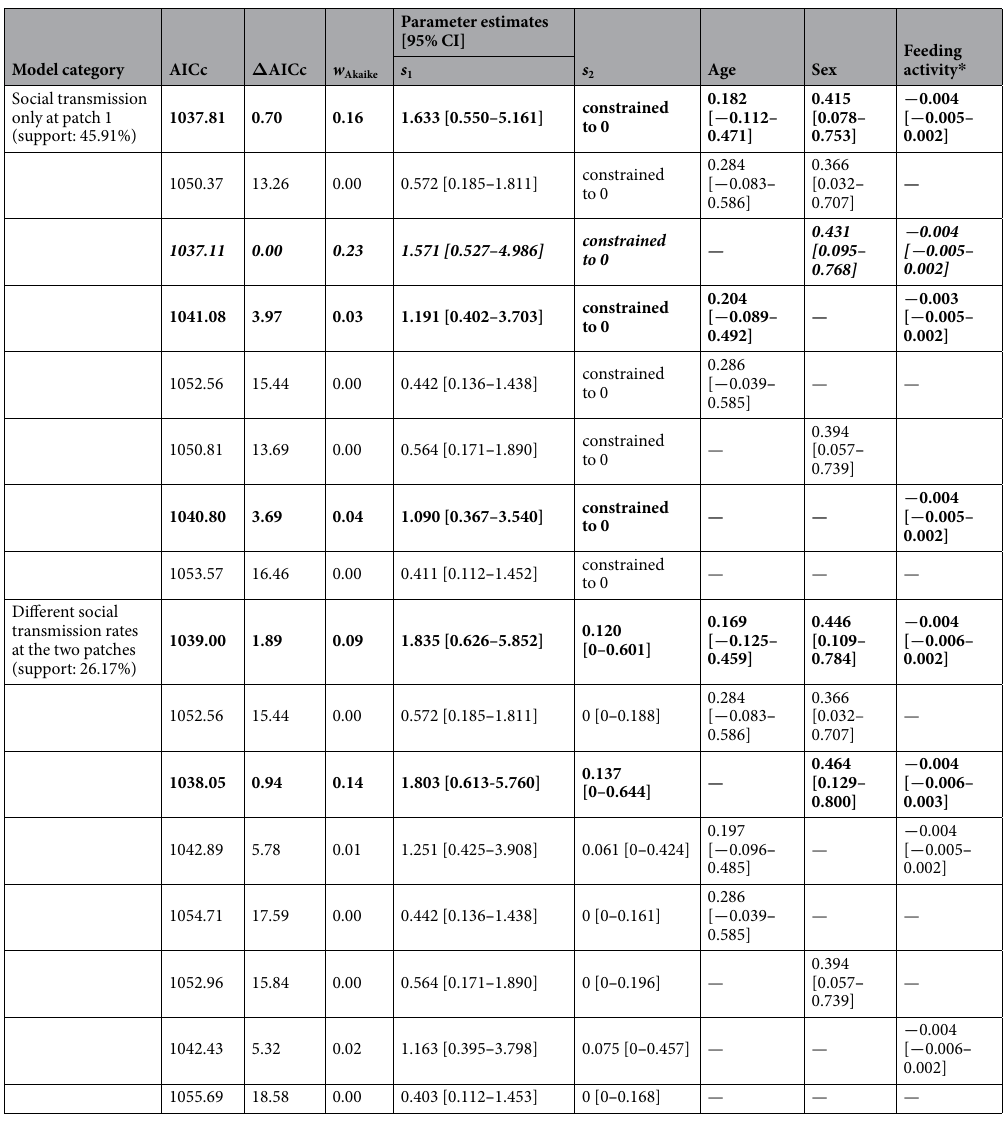
Table 2. Model parameter estimates and their conditional profile likelihood 95% confidence intervals in the two best supported categories of models fitted with following-based networks. * As feeding activity was measured as the total number of visits at the central feeder, the estimated decrease in log odds of discovery corresponds to one unit increase in feeding activity. The model with the lowest AICc is written in italics, while the ‘best models’ set (within 4 Δ AICc) on which we based our inference is written in bold. Other model categories (same social transmission rate at both patches, social transmission only at the second patch, no social transmission at either patches) had very low overall support ( ≤ 0.70%). AICc values and corresponding Akaike weights of all models (both fitted with following-based and homogeneous networks) are shown in Table